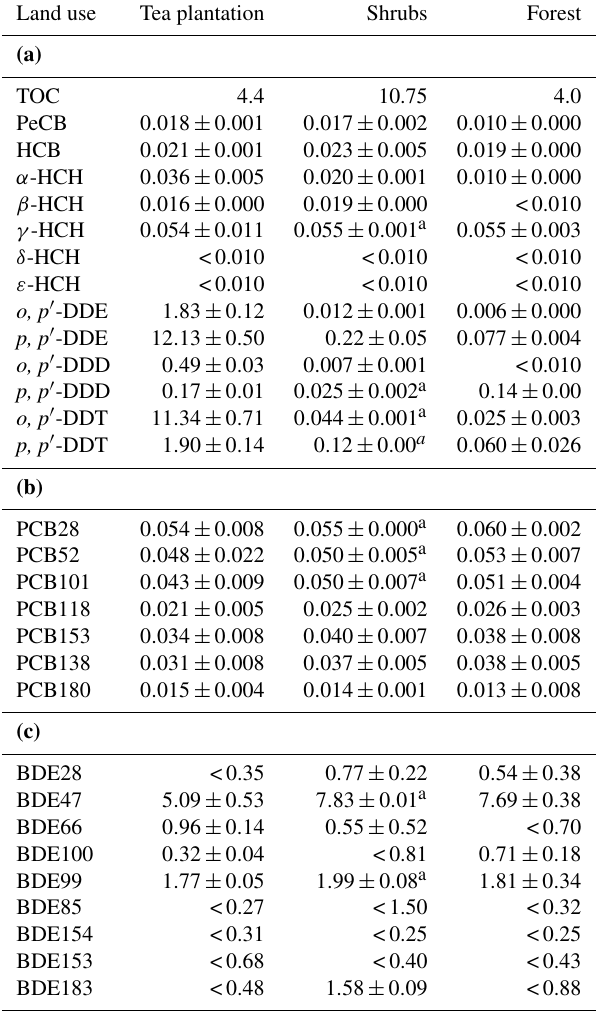
Table 1. Observed concentrations in soil, c s (ngg − 1 ; together with standard deviation based on 3 replicates) of (a) pesticides, (b) PCBs and (c) PBDEs (quantified species only). TOC is total organic car- bon content (% of dry mass).